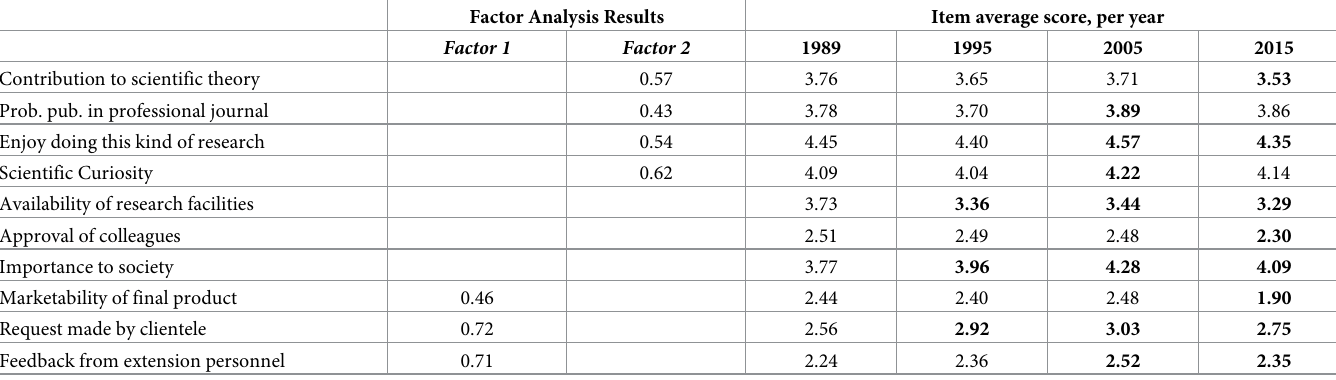
S1 Fig. Comparing the proportion of faculty across bins of attitudes, by basic vs. applied research. This figure displays the proportion of faculty across bins of intrinsic (A) and extrin-